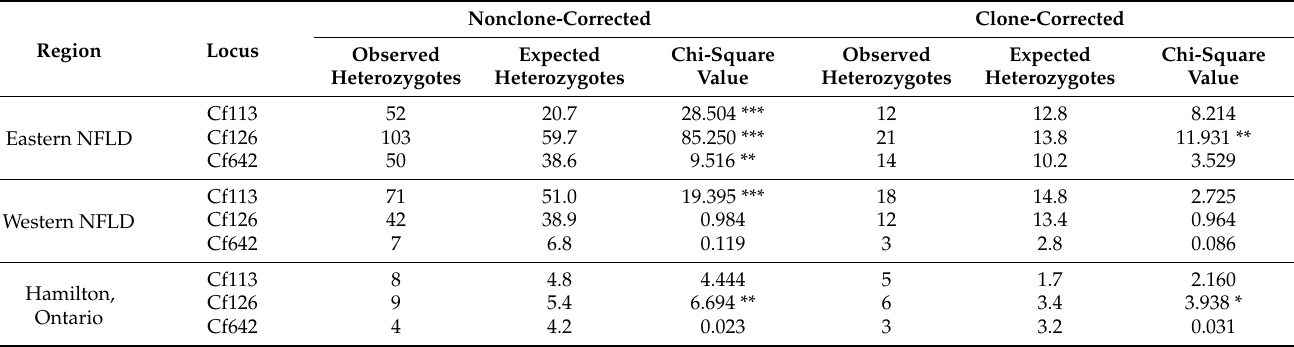
Table 2. Chi-square tests for Hardy–Weinberg equilibrium within the three regional populations of C. enelensis in